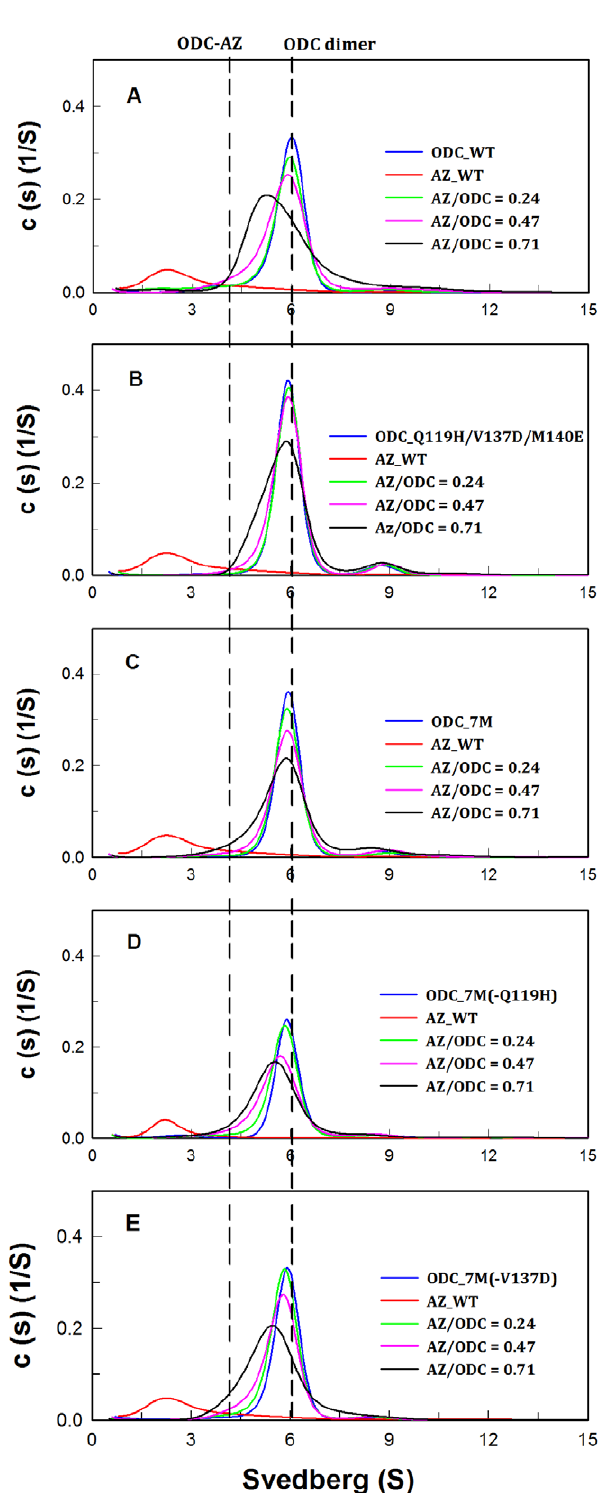
Figure 2. The continuous sedimentation coefficient distribu- tions of human ODC mutant enzymes in the presence of AZ. The concentration of ODC was fixed at 0.3 mg/mL with an AZ concentration of 0.03,0.06or 0.09 mg/mL (the molar ratio of AZ/ODC was 0.24,0.47 and 0.71, respectively). The sedimentation velocity data were globally fitted with the SEDPHAT program to calculate the K d values of the ODC-AZ heterodimer (Table 2). A: ODC_WT; B: ODC_Q119H/V137D/M140E; C: ODC_7M; D: ODC_7M(-Q119H); E: ODC_7M(-V137D).